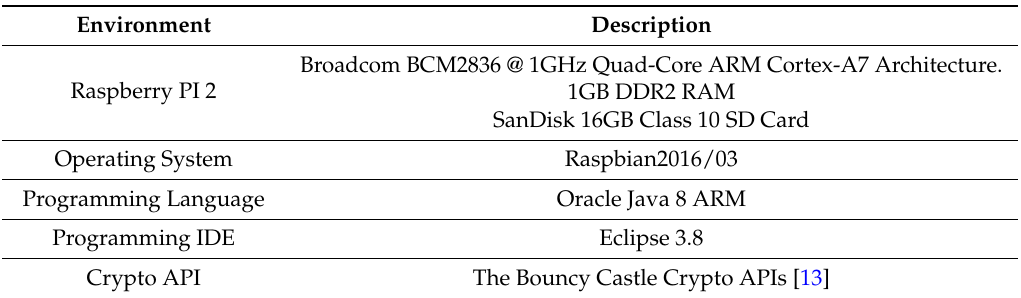
Table 3. Implementation